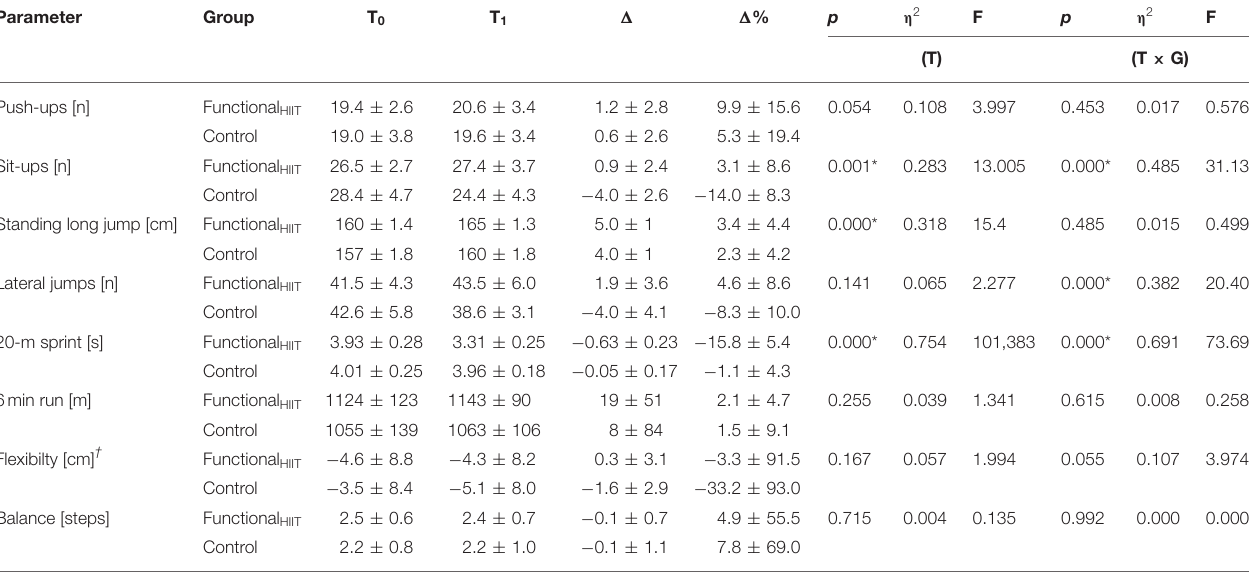
TABLE 3 | Parameters of functional strength and endurance (means ± SD) for the Functional HIIT and Controle group before (T 0 ) and after (T 1 ) the 4 week intervention.